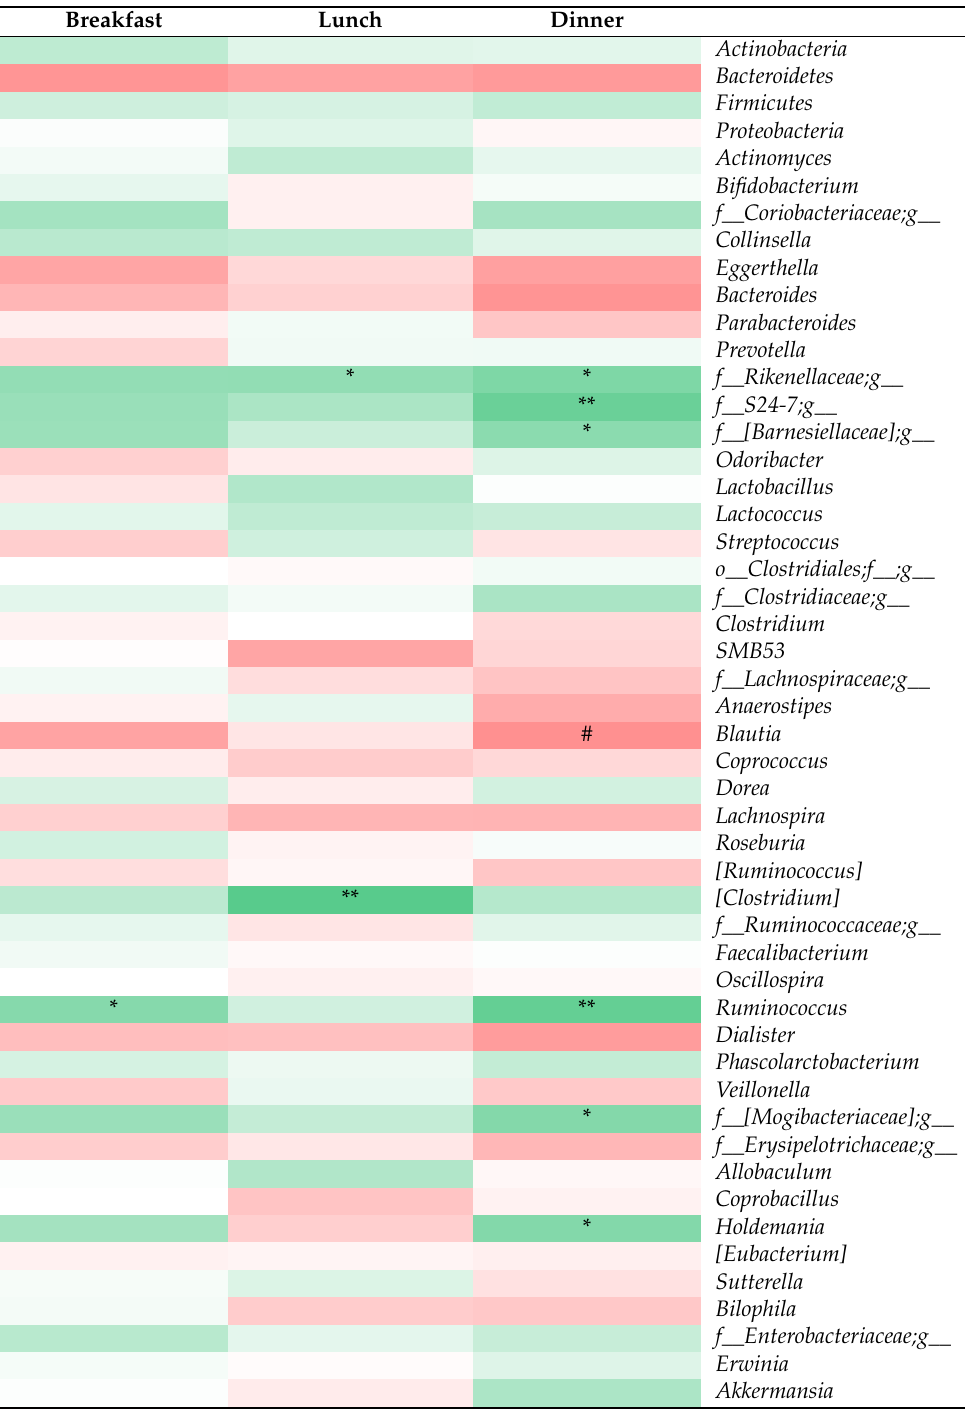
Table 4. Correlation between gut bacteria and blood glucose levels of 4-hour AUC after each